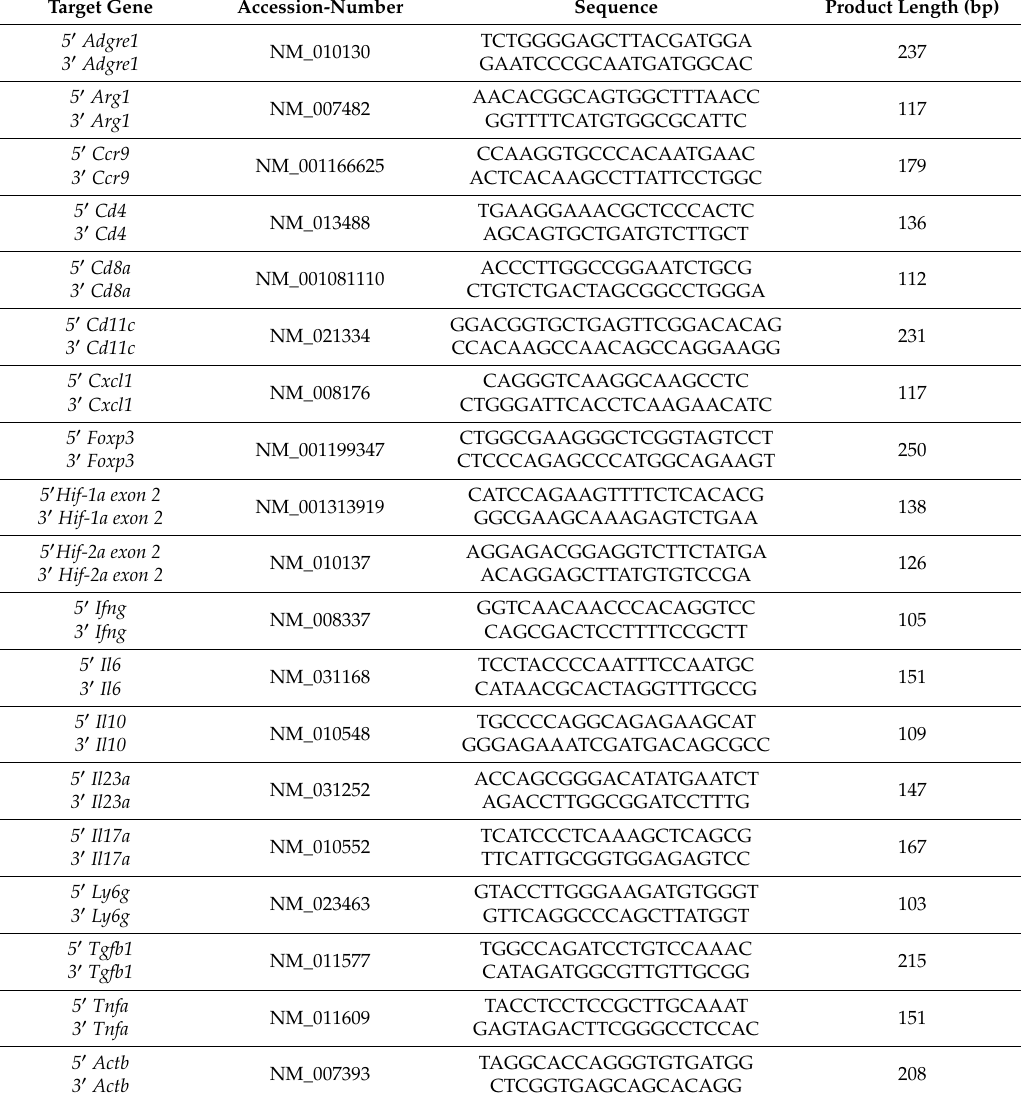
Table 4. Primer sequence and product